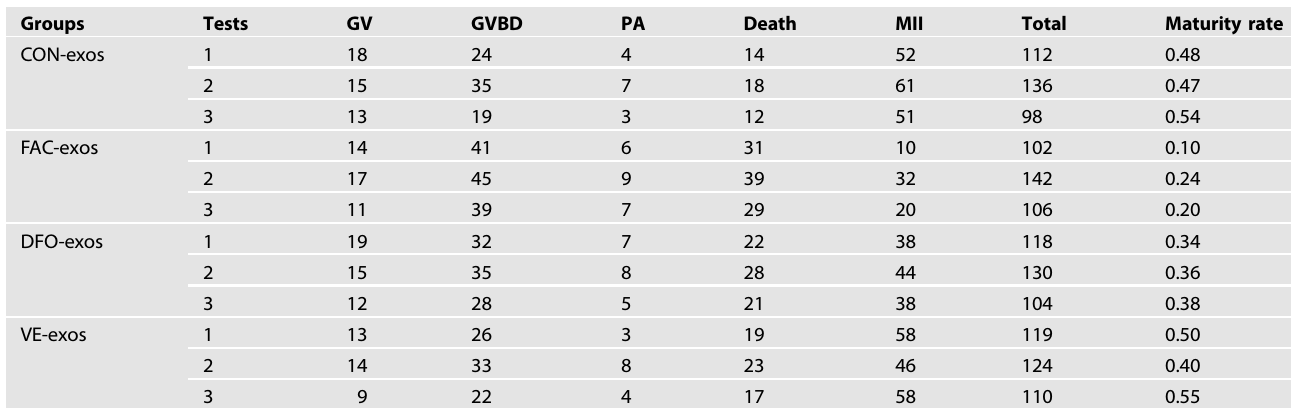
Table 2. Mouse oocyte maturation after exosome